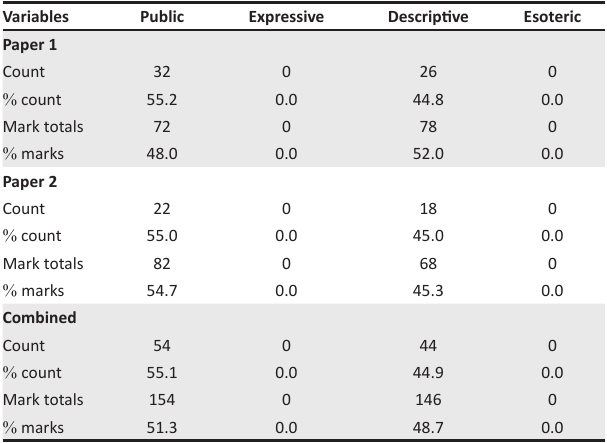
TABLE 1: Electricity Tariffs